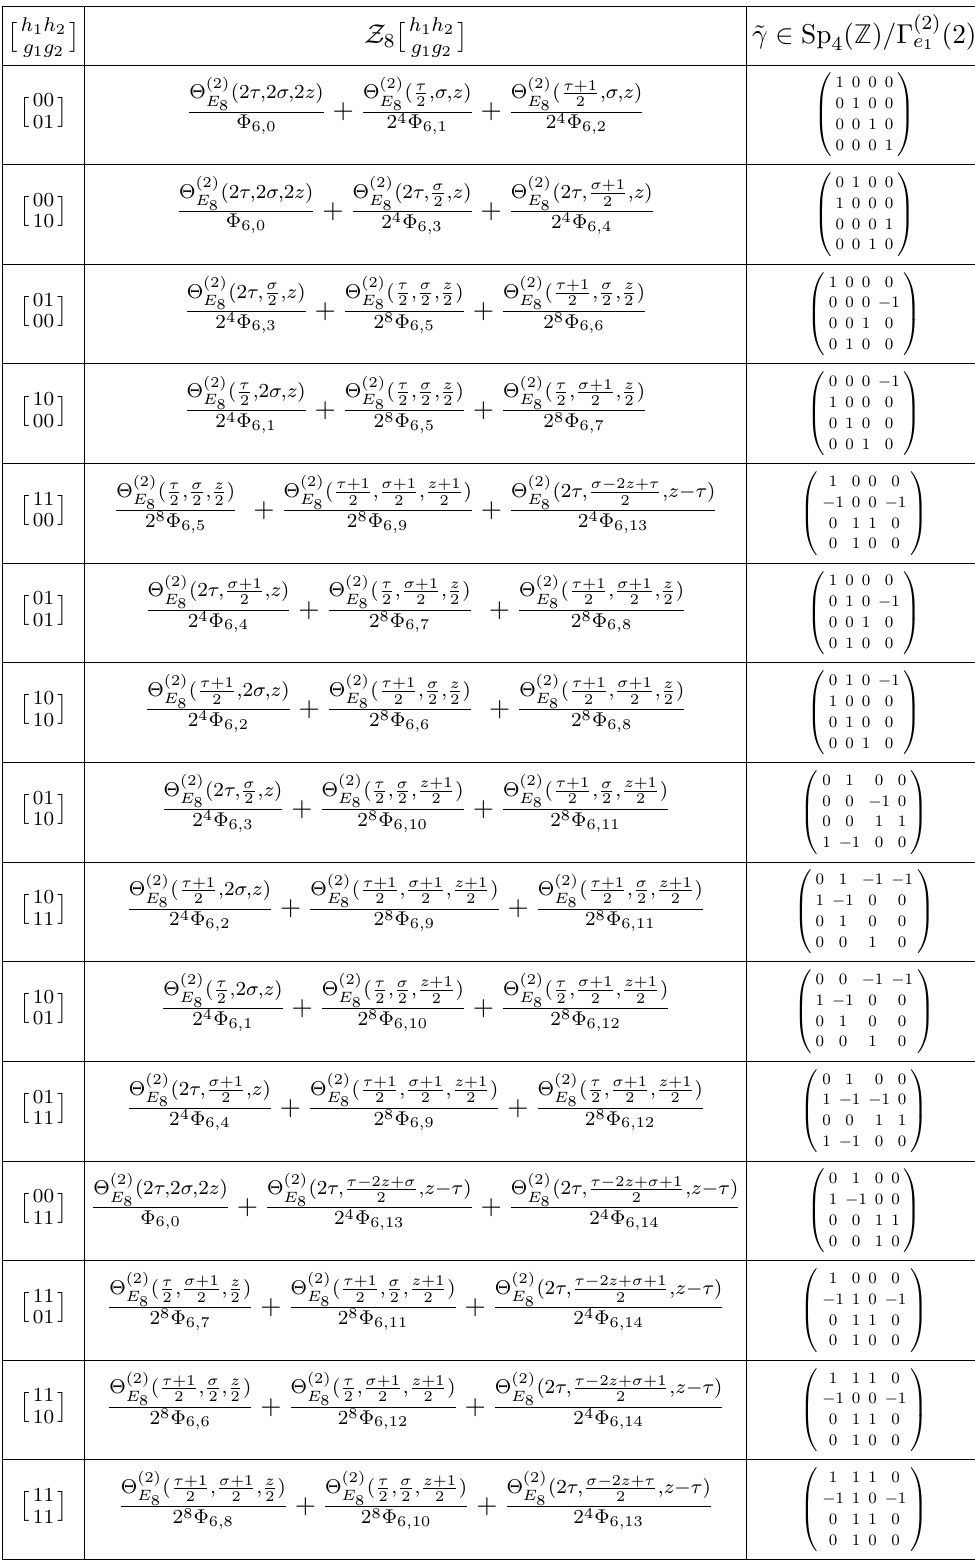
Table 1 . Chiral genus two orbifold blocks for the heterotic Z 2 CHL model (taken from